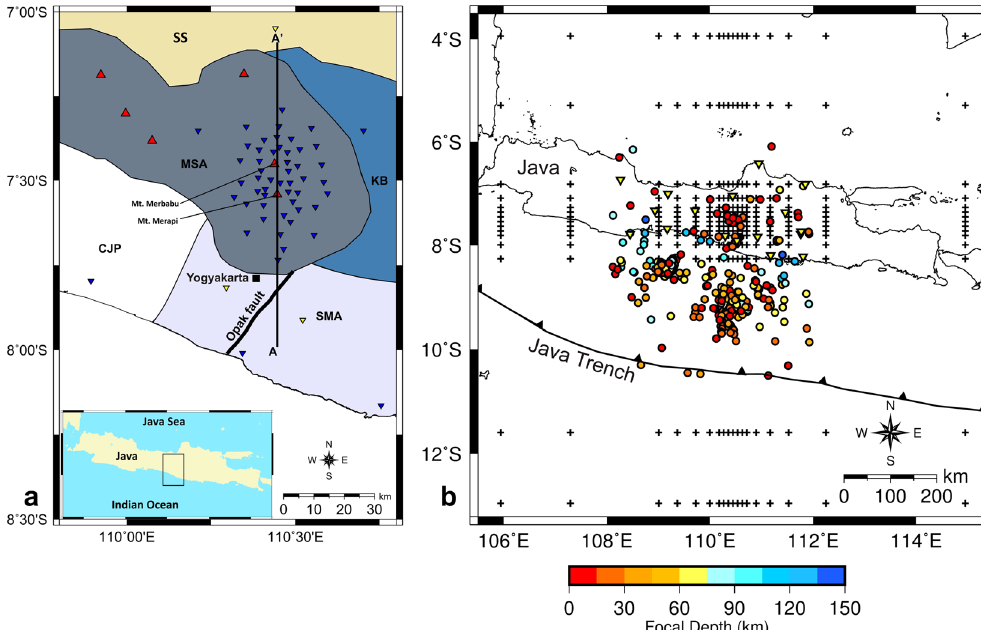
Figure 1. Maps of the study area. ( a ) The main structural units of central Java: Central Java Province (CJP), Modern Sunda Arc (MSA), Sunda Shelf (SS), Kendeng Basin (KB), and Southern Mountain Arc (SMA) (modified from 1 ). Symbols: blue and yellow reverse triangles depict the distribution of seismographic stations of the DOMERAPI and BMKG networks, respectively, and red triangles represent volcanoes. The South-North (A-A’) line shows the location of vertical sections presented in Figs 3 and 4. ( b ) Epicentral distribution of relocated events upon SIMULPS12 using a 3-D velocity structure and grid nodes used for tomographic inversions (crosses). Yellow reverse triangles depict the locations of the BMKG stations. Figures 1–3 were produced using the Generic Mapping Tools (GMT) by Wessel and Smith 34